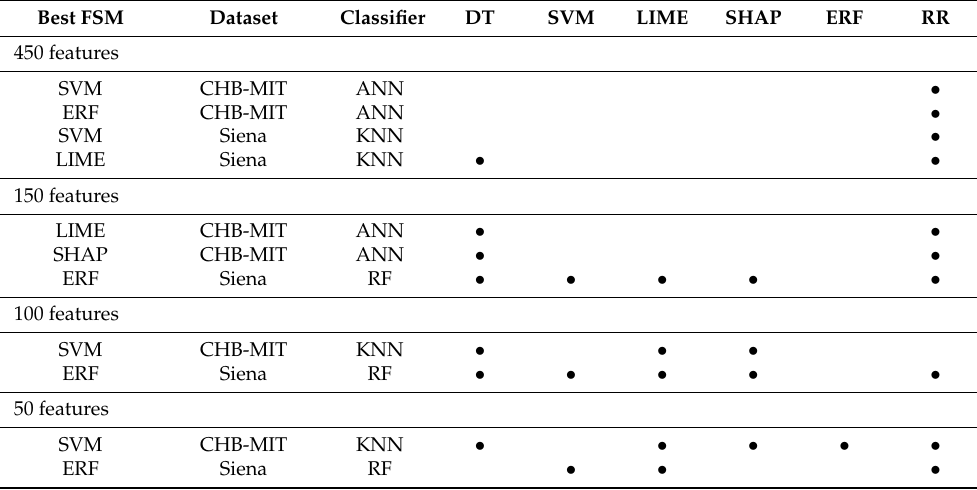
Table 10. Comparison of the best C-FSM when FS1 is used. It is compared against the rest of the FSMs. • denotes p < 0.05.